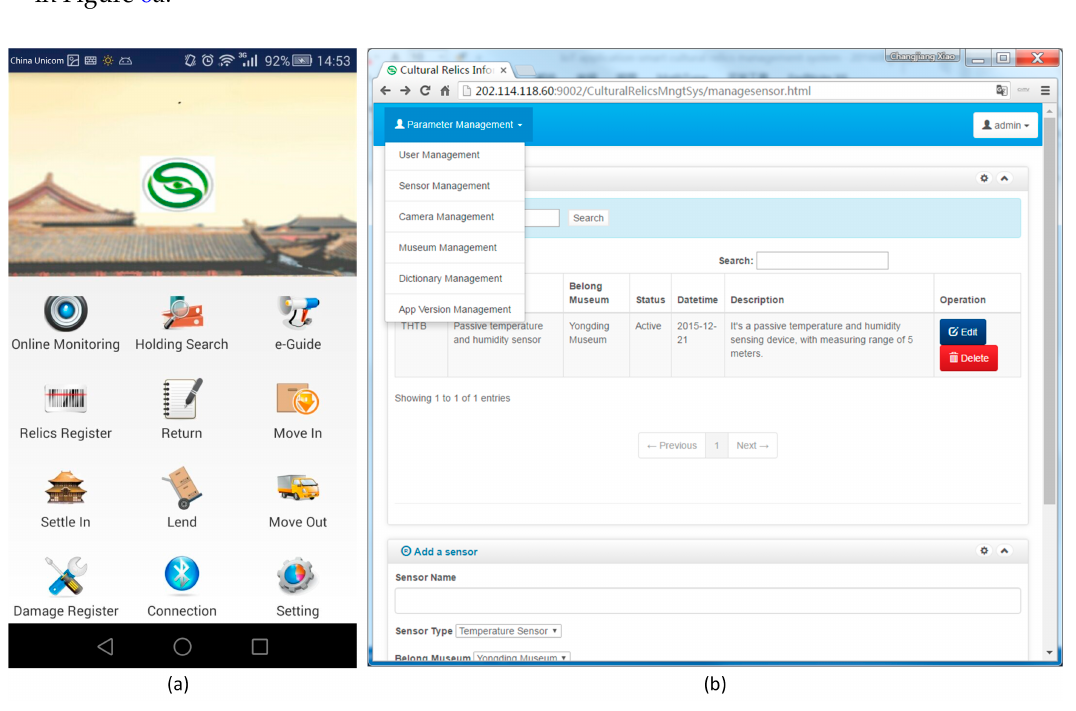
Figure 6. Data collection and administration software: ( a ) Android-based middleware and application; ( b ) Server-side cultural relics information management system.